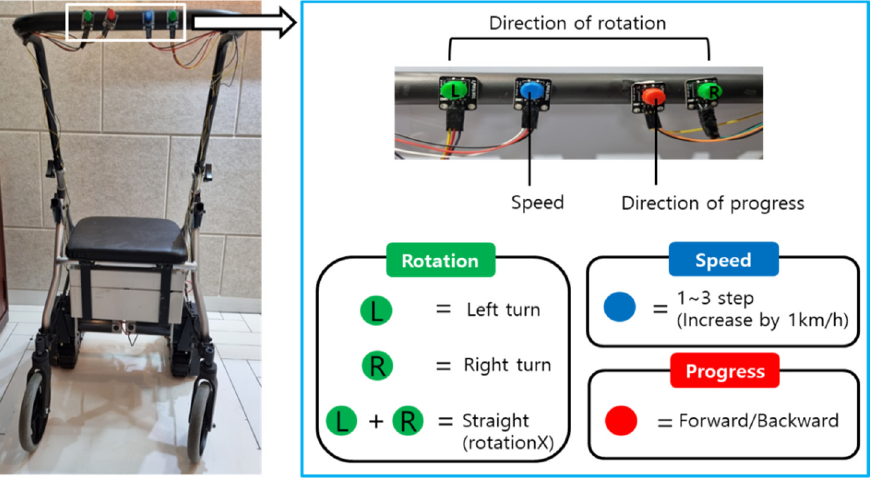
Figure 4. Control part of caterpillar-type walker.